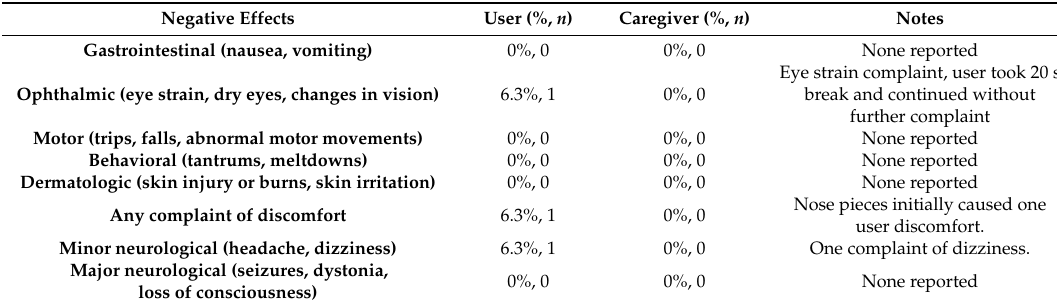
Table 3. Negative Effects. Issues reported by users or caregivers during the testing session are reported below.